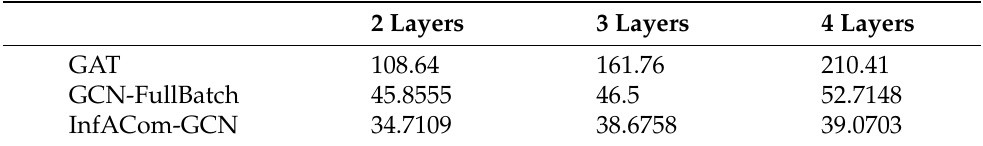
Table 3. Memory usage in megabytes for Citeseer dataset using different numbers of layers (the number of hidden units is 128).